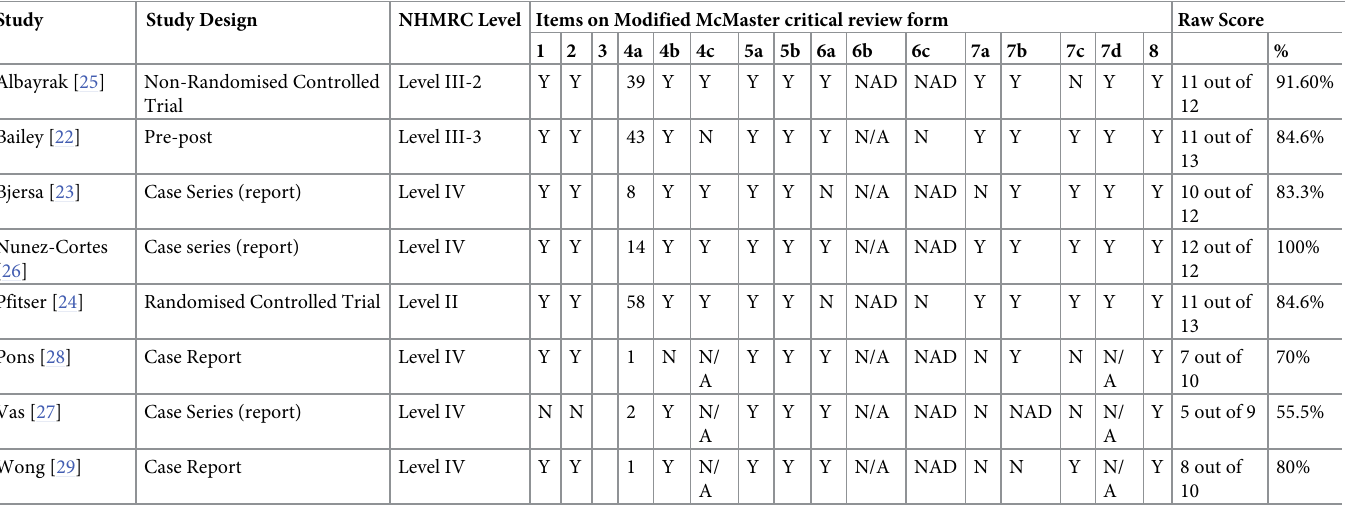
Table 1. Levels of evidence and modified McMaster results of methodological